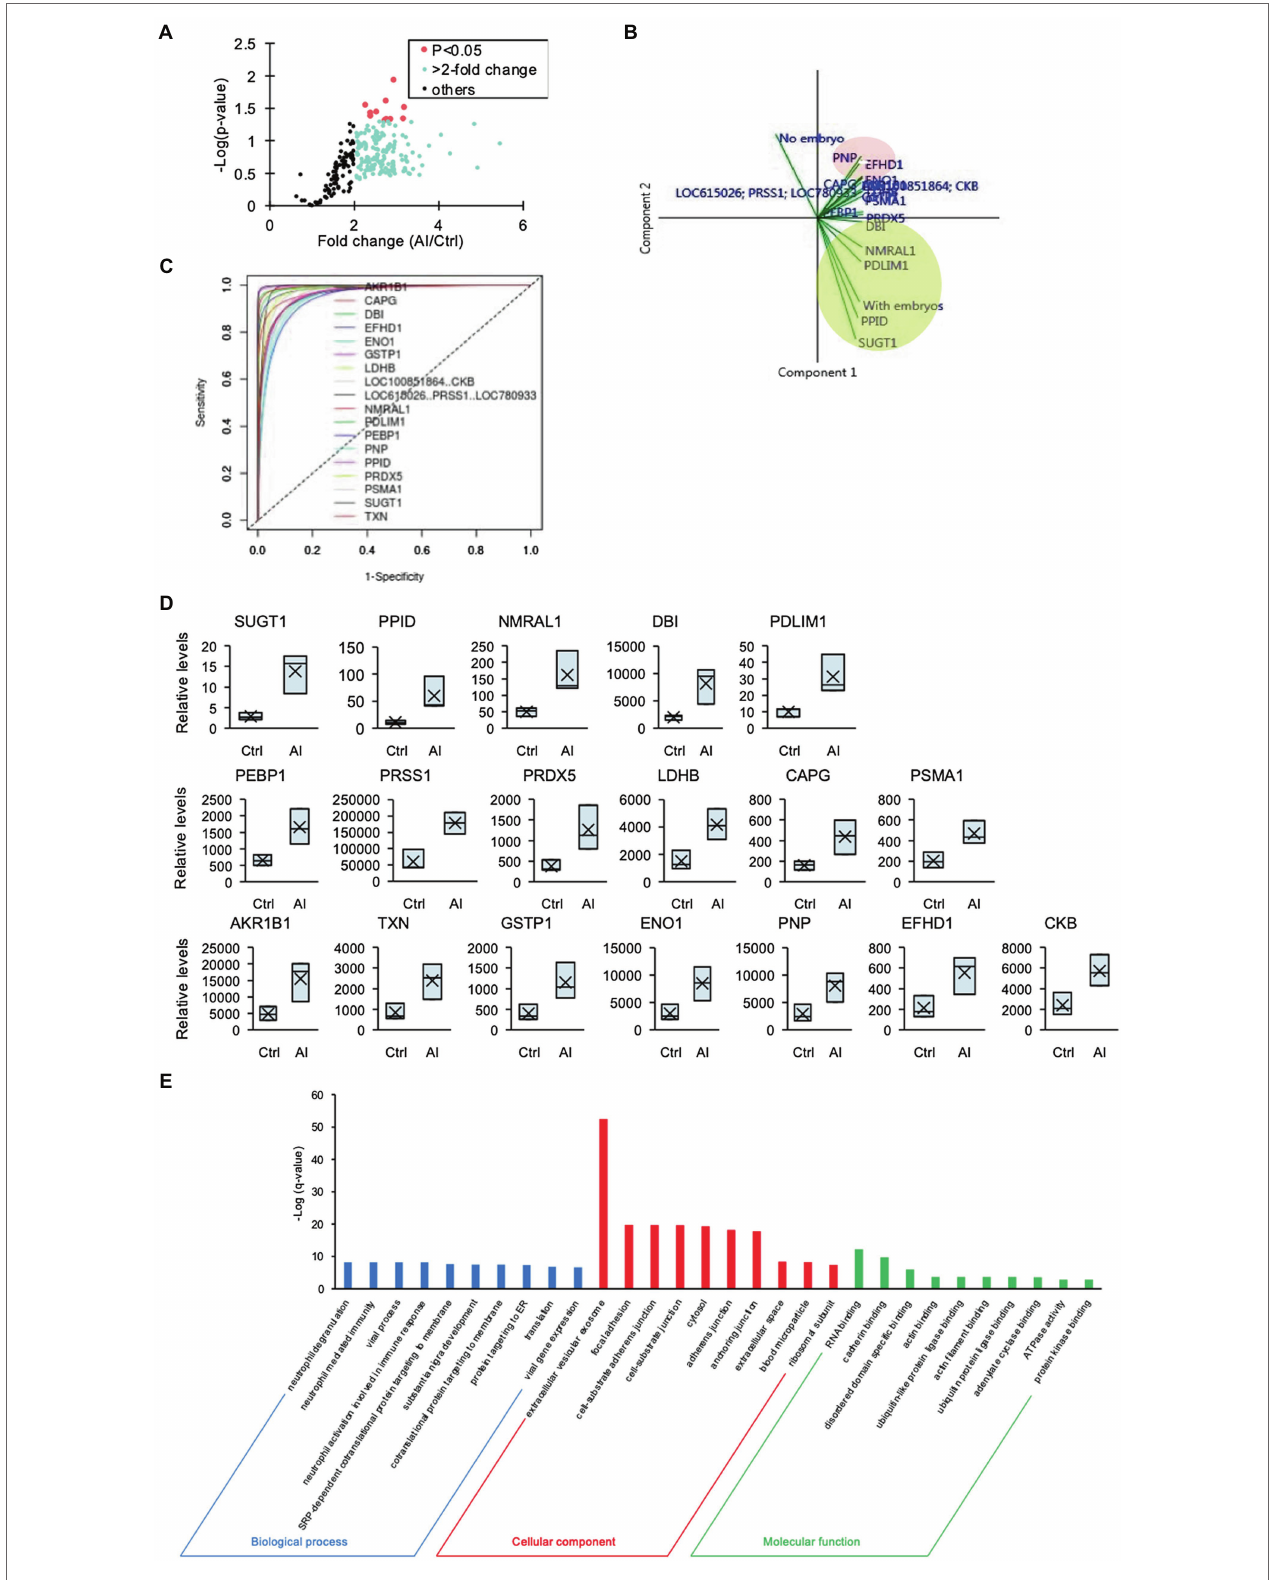
FIGURE 2 | The iTRAQ analysis of uterine flush (UF) collected on D7. (A) Volcano plot showing the protein levels found by the iTRAQ analysis. The proteins